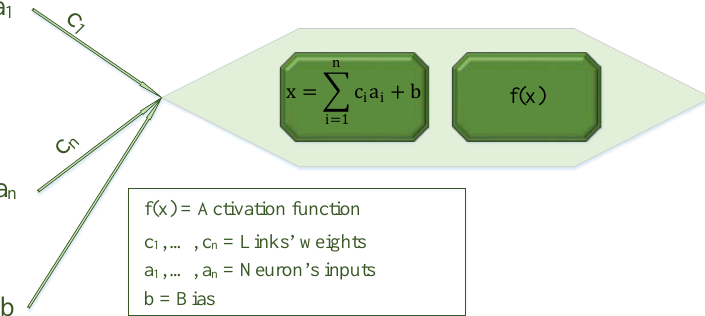
Figure 3. A schematic neuron.